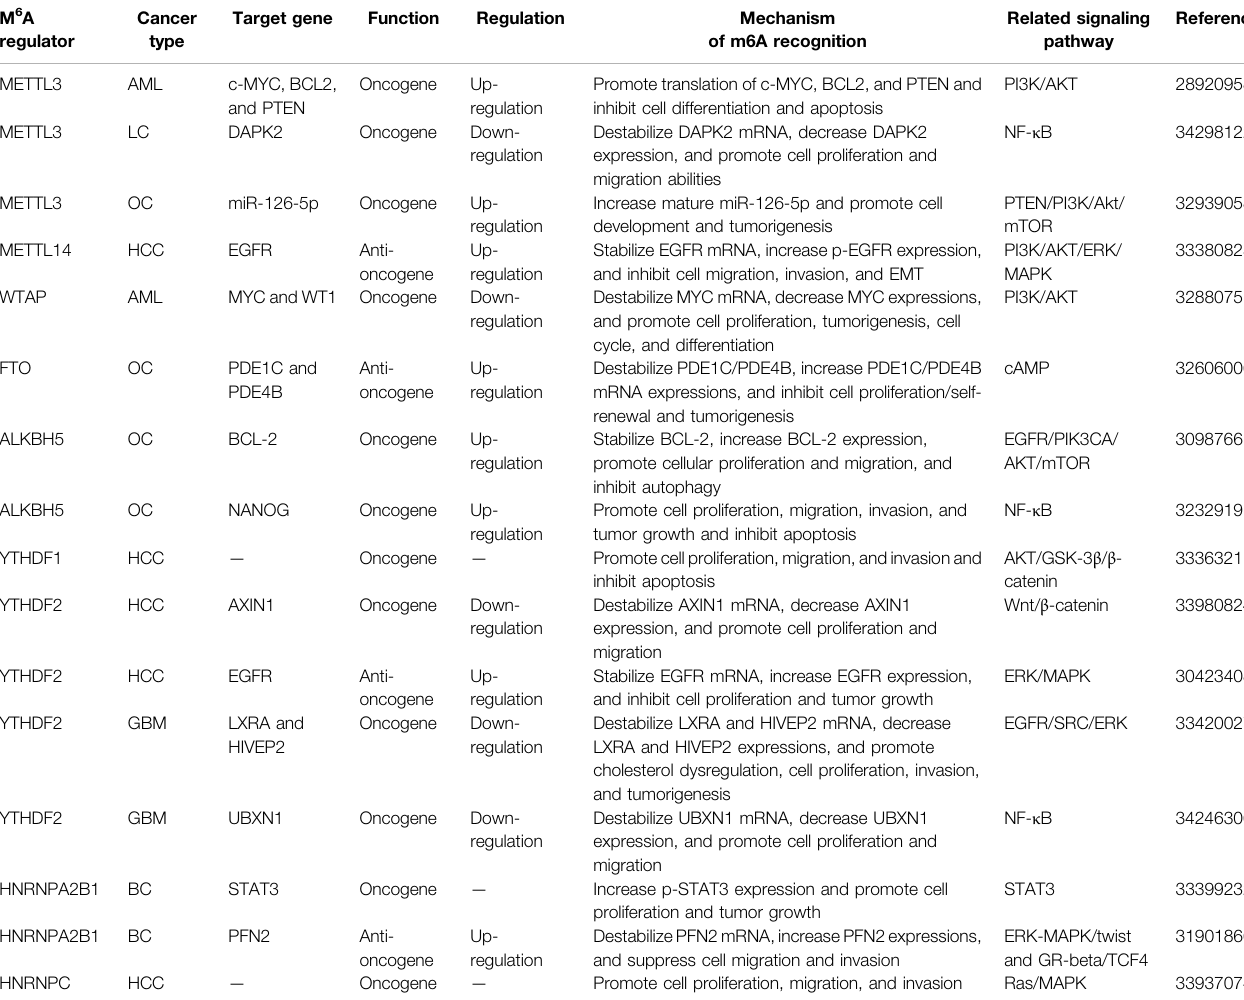
TABLE 3 | Signaling pathways involved in m 6 A RNA